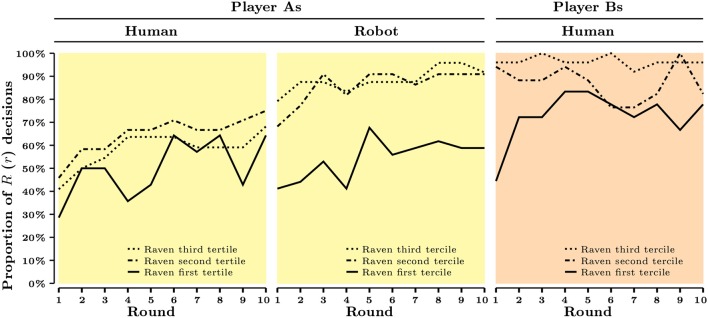
Raven's test score and aggregate behavior across rounds and treatments.